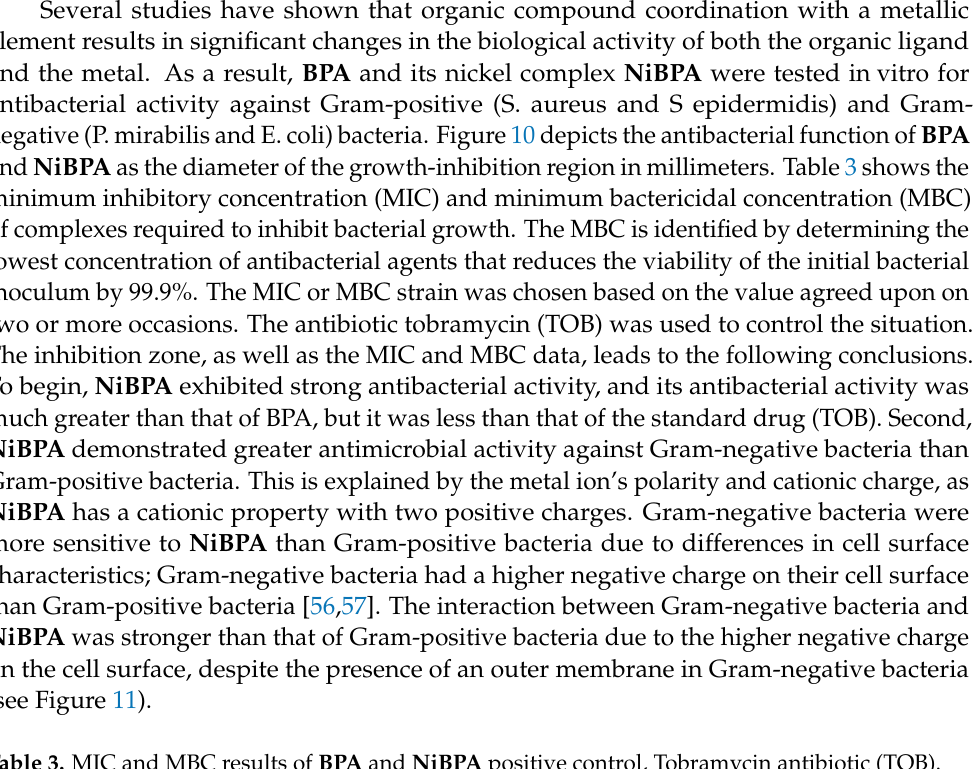
Table 3. MIC and MBC results of BPA and NiBPA positive control, Tobramycin antibiotic (TOB).